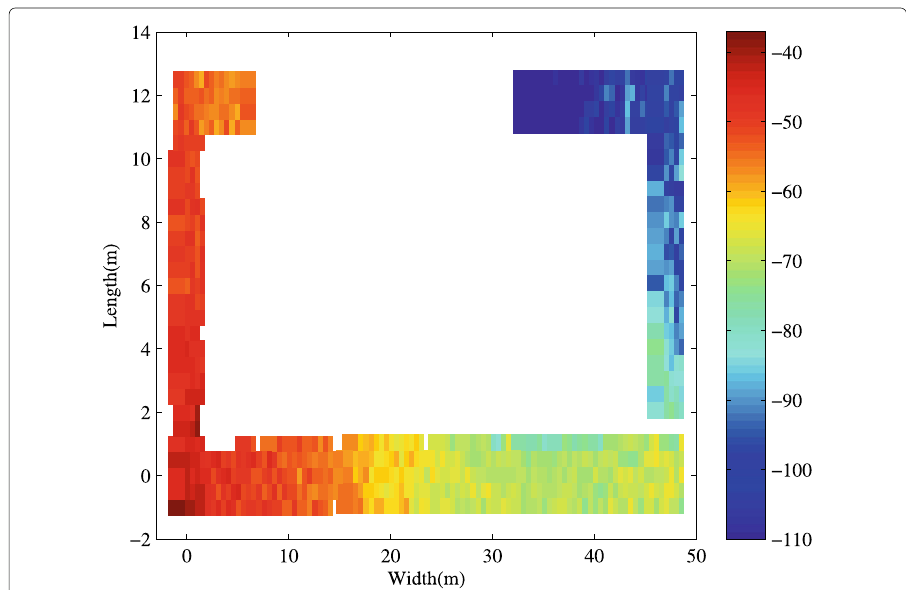
Fig. 12 Signal distribution of radio map built by traditional method